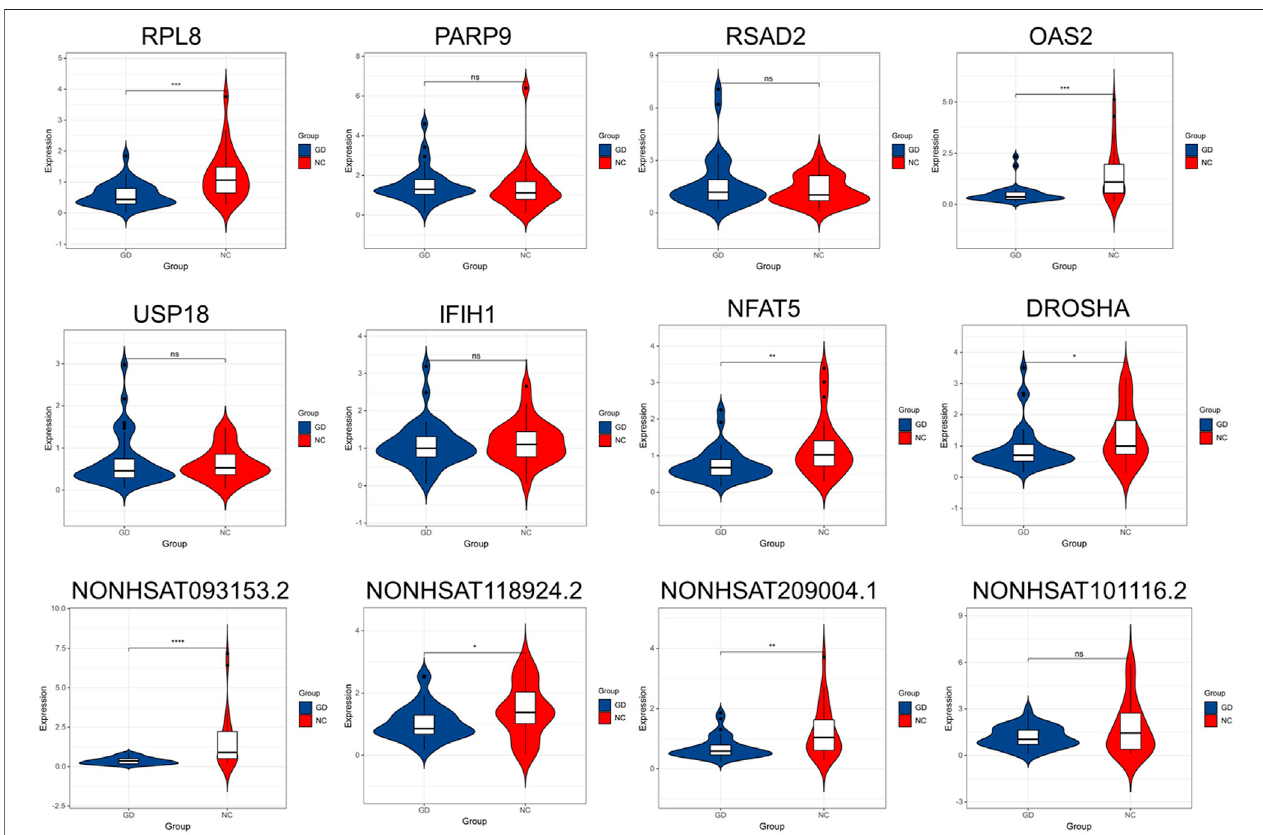
FIGURE 9 | Validation of key lncRNAs and mRNAs by qRT-PCR. The expression of RPL8, OAS2, NFAT5, DROSHA, NONHSAT093153.2, NONHSAT118924.2, and NONHSAT209004.1 was signi fi cantly decreased in GD group ( p < 0.001, p < 0.001, p < 0.01, p < 0.05, p < 0.001, p < 0.05, and p < 0.01, respectively). No signi fi cant difference was found in the expression level of PARP9, RSAD2, OAS2, USP18 A, and NONHSAT101116.2 between GD and normal control (NC) groups. p p < 0.05, pp p < 0.01, ppp or pppp p < 0.001, ns, not signi fi cant.